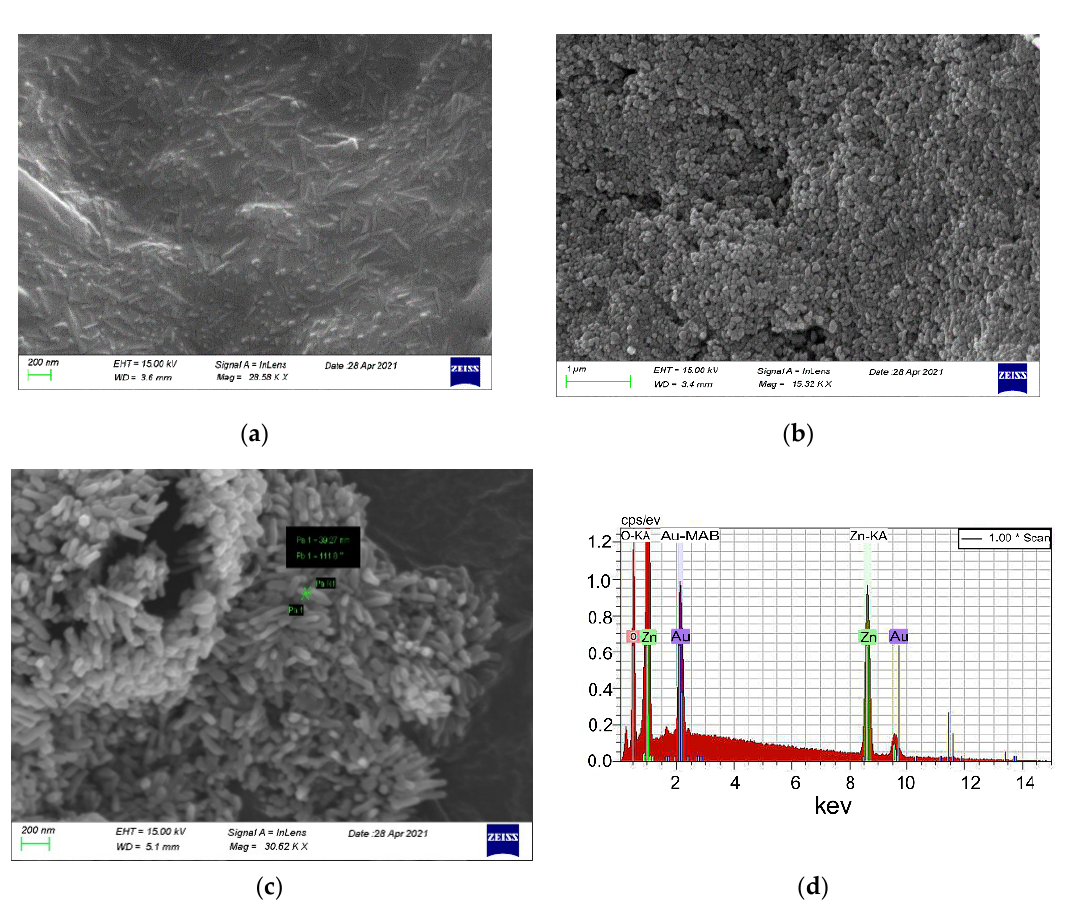
Figure 5. Scanning electron microscopy (SEM) images of the Duranit balls surface ( a ) before, and ( b , c ) after the ZnO deposition. ( d ) EDX spectrum of the Duranit balls surface after the deposition.